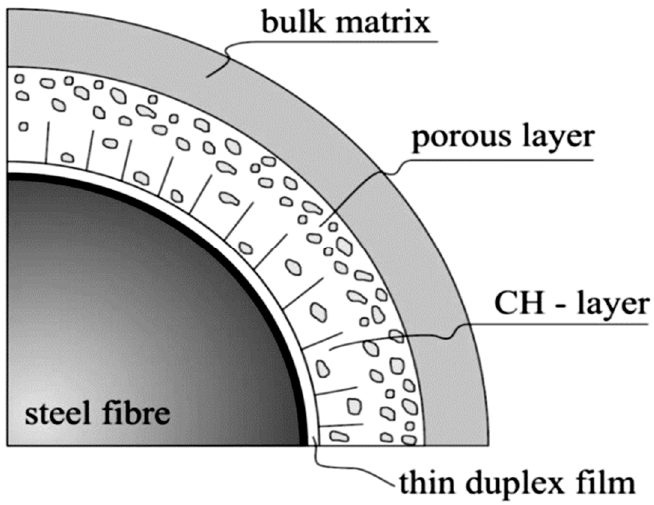
Figure 4. Transverse cross-section of the interfacial zone in the matrix (ITZ) between fibre and matrix [49].